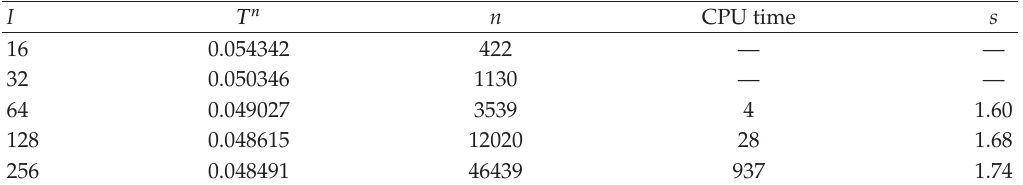
Table 7: Numerical blow-up times, numbers of iterations, CPU times (cid:3) seconds (cid:4) and orders of the approximations obtained with the explicit Euler method defined in (cid:3) 8.2 (cid:4) – (cid:3) 8.4 (cid:4) .